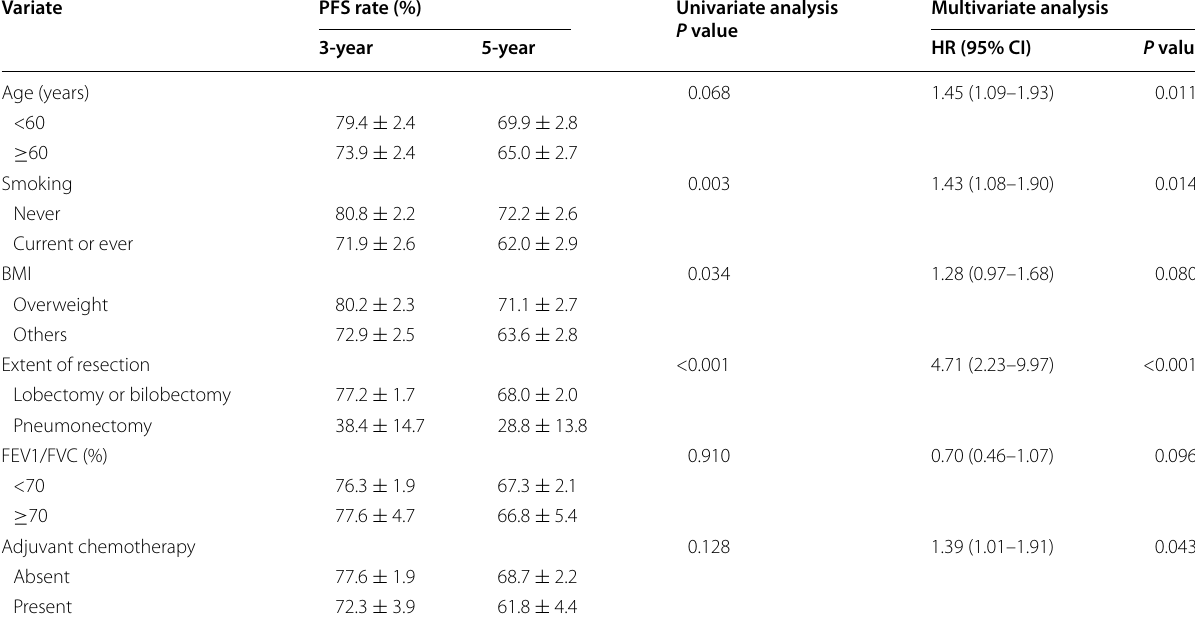
The data of survival rates are expressed as mean